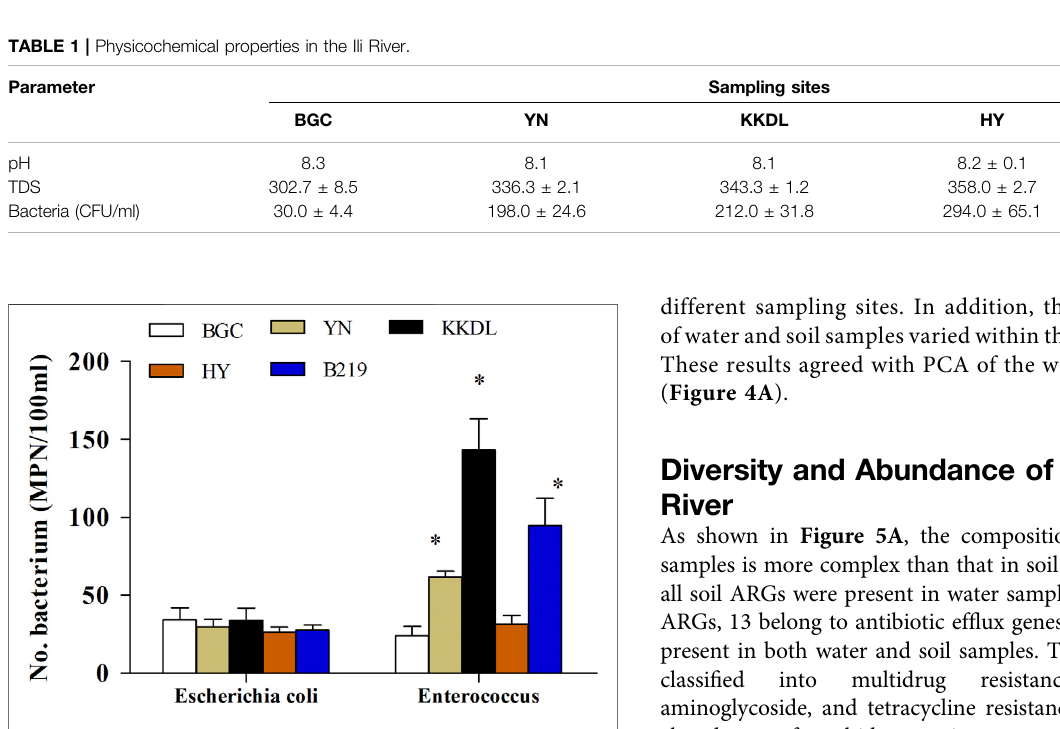
FIGURE 2 | Concentration of fecal indicator bacteria (FIB) in fi ve sampling sites.